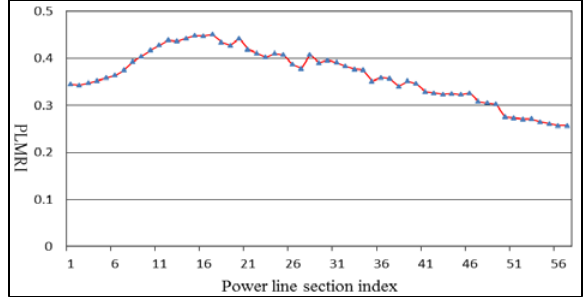
Figure 9 PLMRIs for each power line section